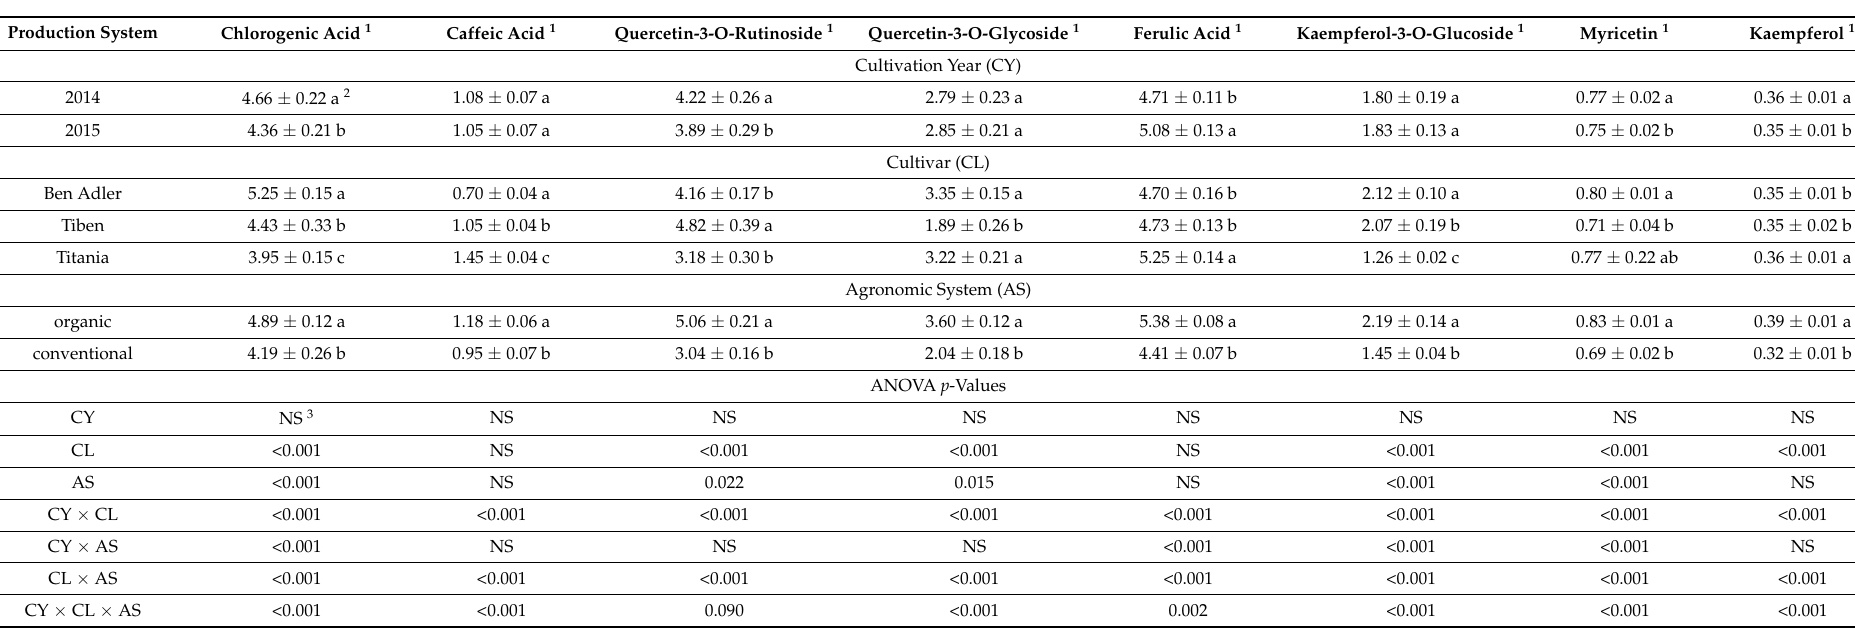
Table 3. The main effects of, and between, cultivation year, cultivar and agronomic system on the content of individual phenolic acids and flavonoids in blackcurrant fruits (in mg 100 g